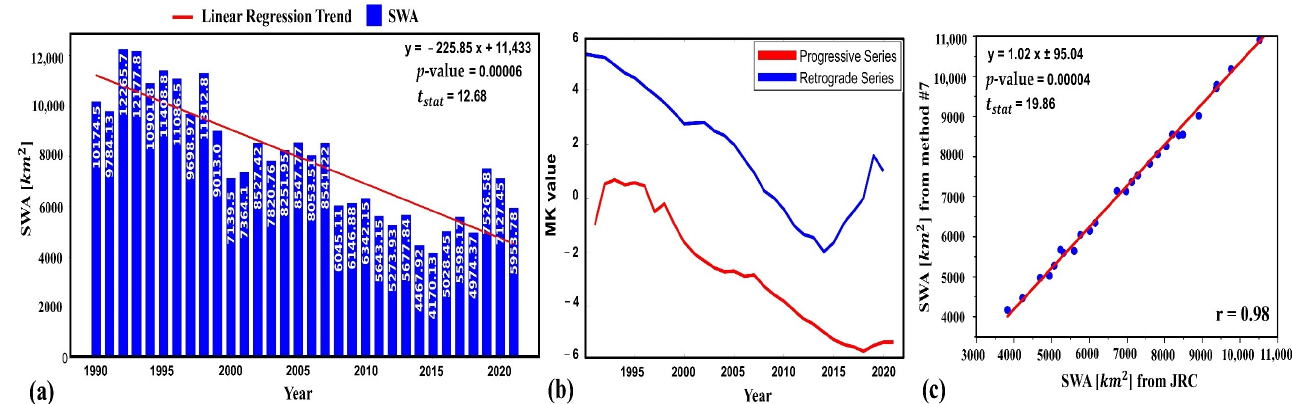
Figure 6. ( a ) The 32-year SWA dynamics in Iran (including the Qareh-Qum Basin), ( b ) the SQMK test results for SWA variations in Iran, ( c ) correlation analysis between results of the median composite of the JRC monthly water maps and the 7th WMR (Table 2).